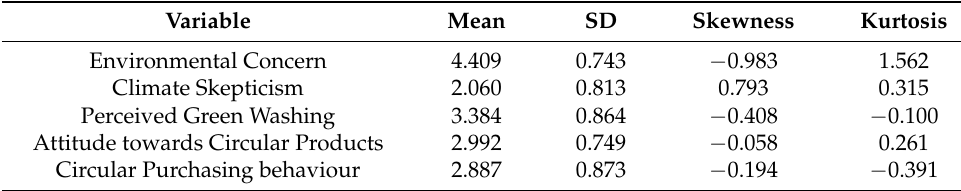
Table 3. Descriptive